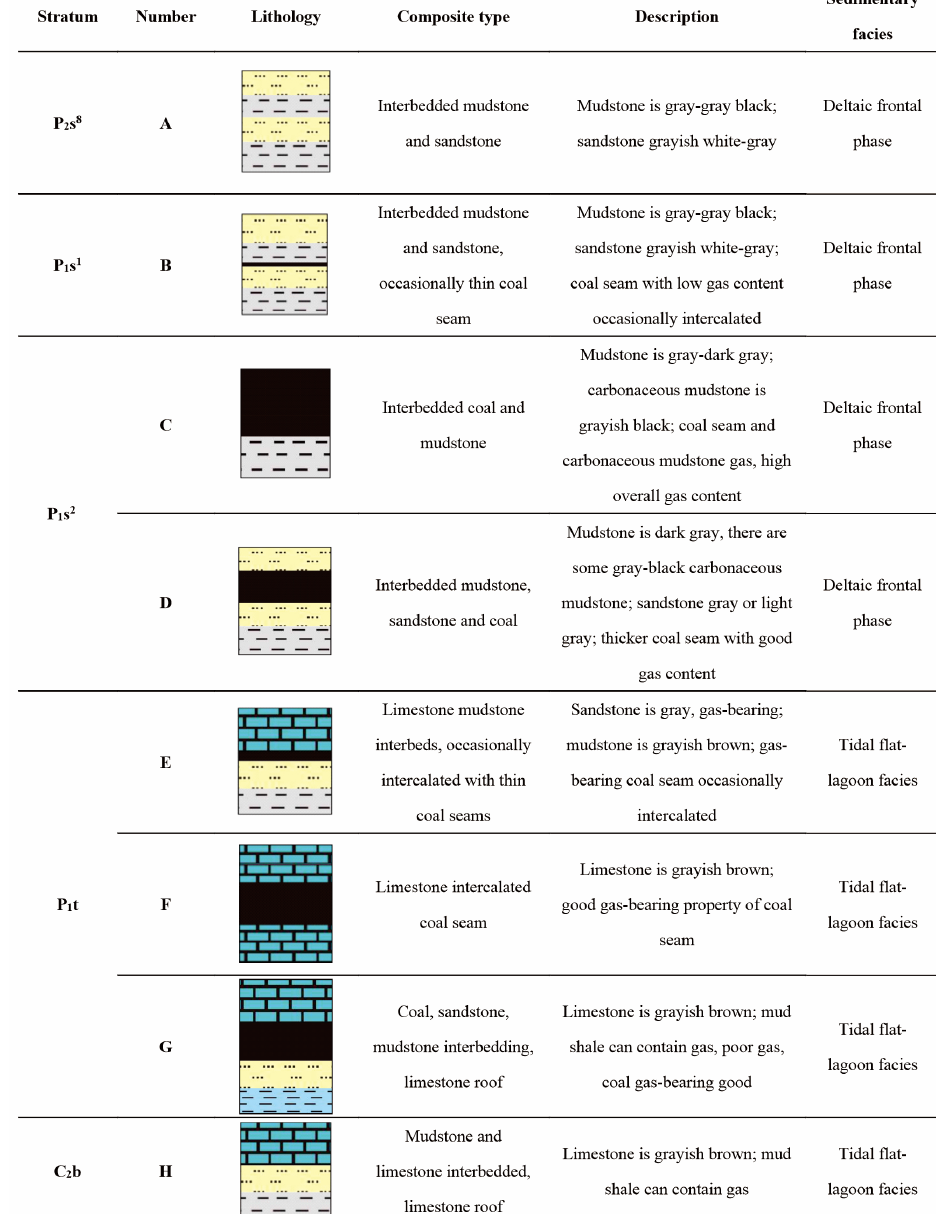
Figure 3. Lithofacies assemblage types of Daning–Jixian Block.